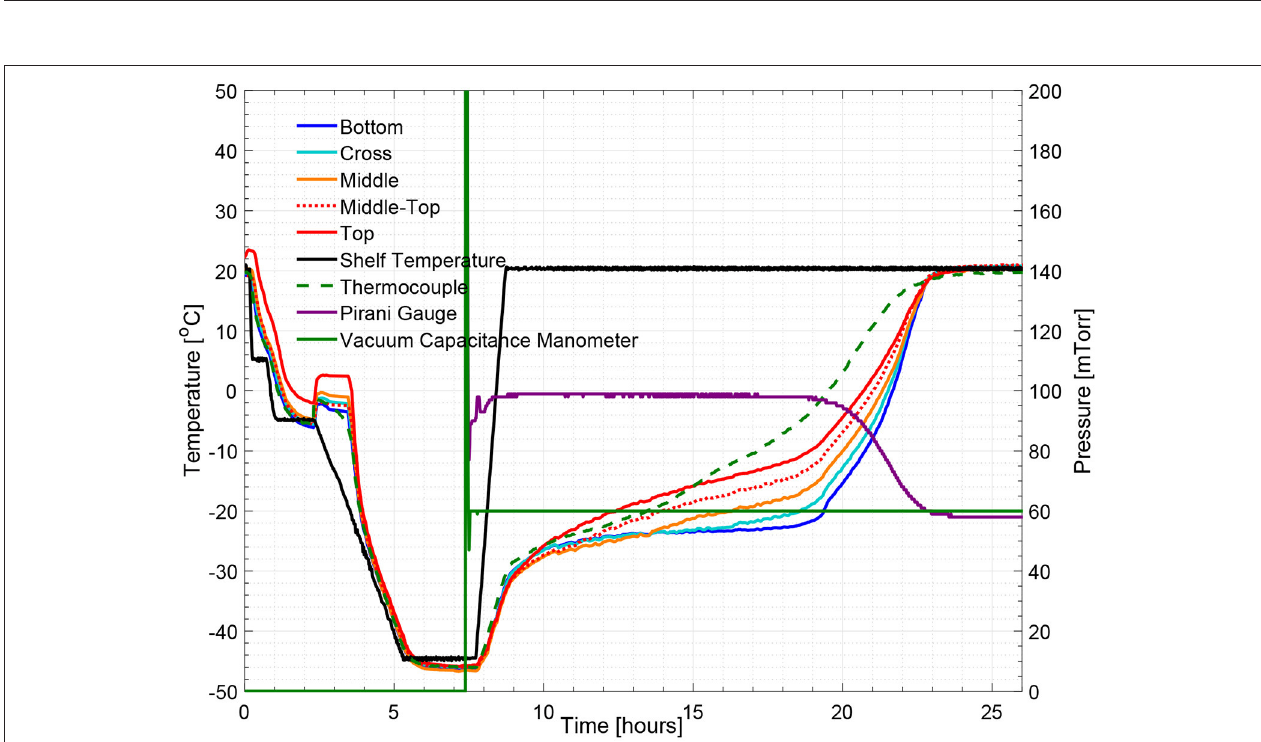
FIGURE 7 | Measured temperature and pressure over time profile of 3% w/v mannitol solution (cycle 4).